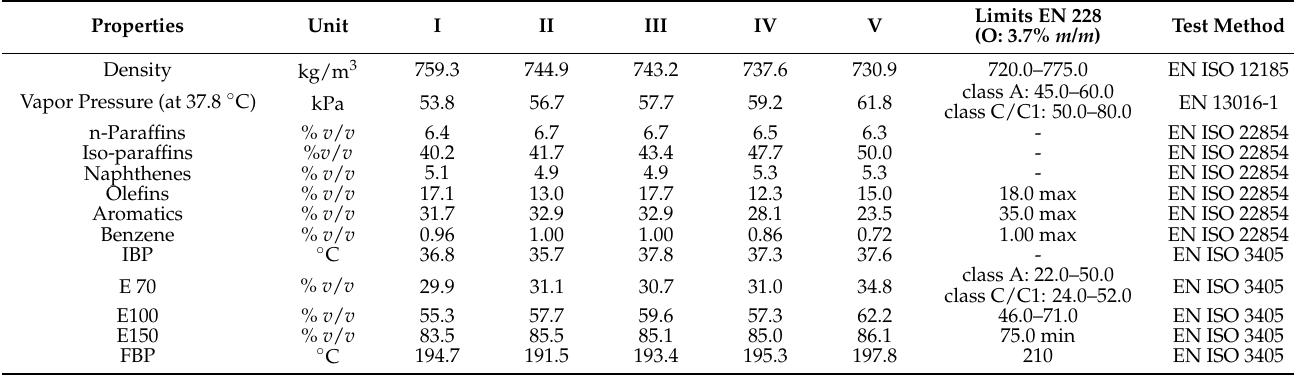
Table 3. Properties and composition of base fuels.